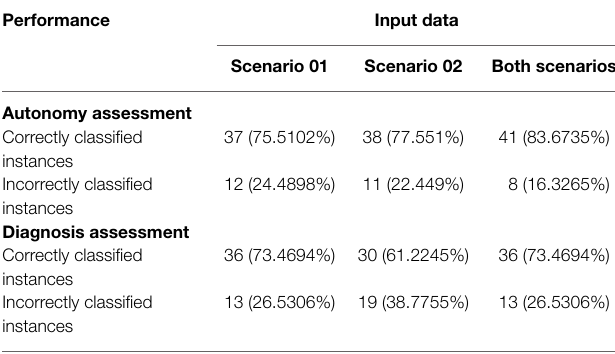
TABLE 7 | Classification results